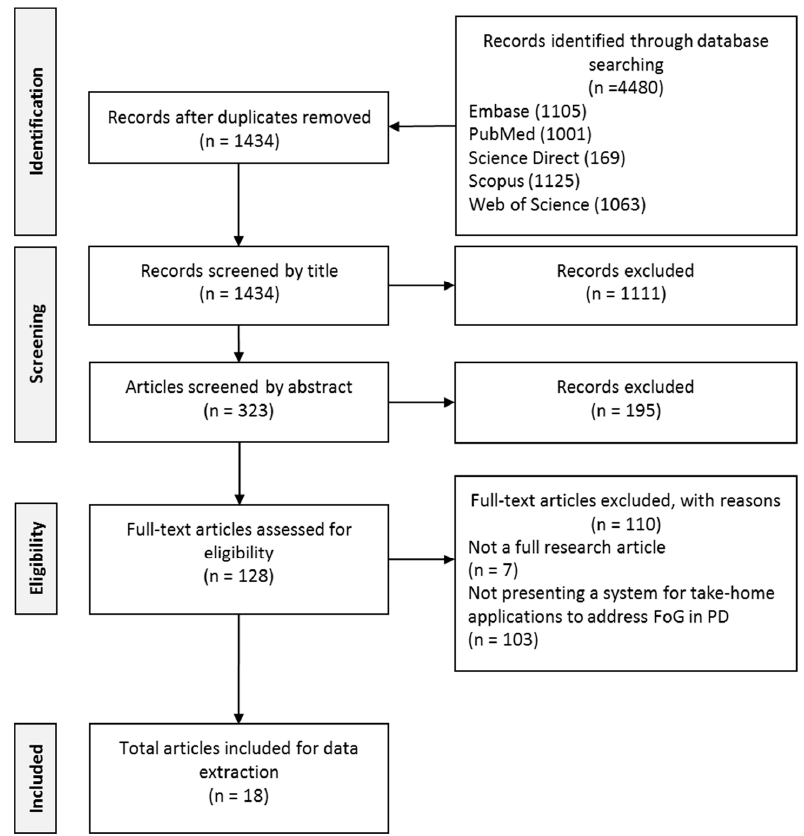
Figure 2. PRISMA flow diagram of study selection.